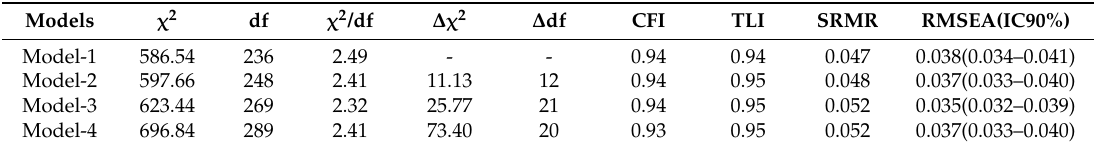
Table 3. Invariance by gender.